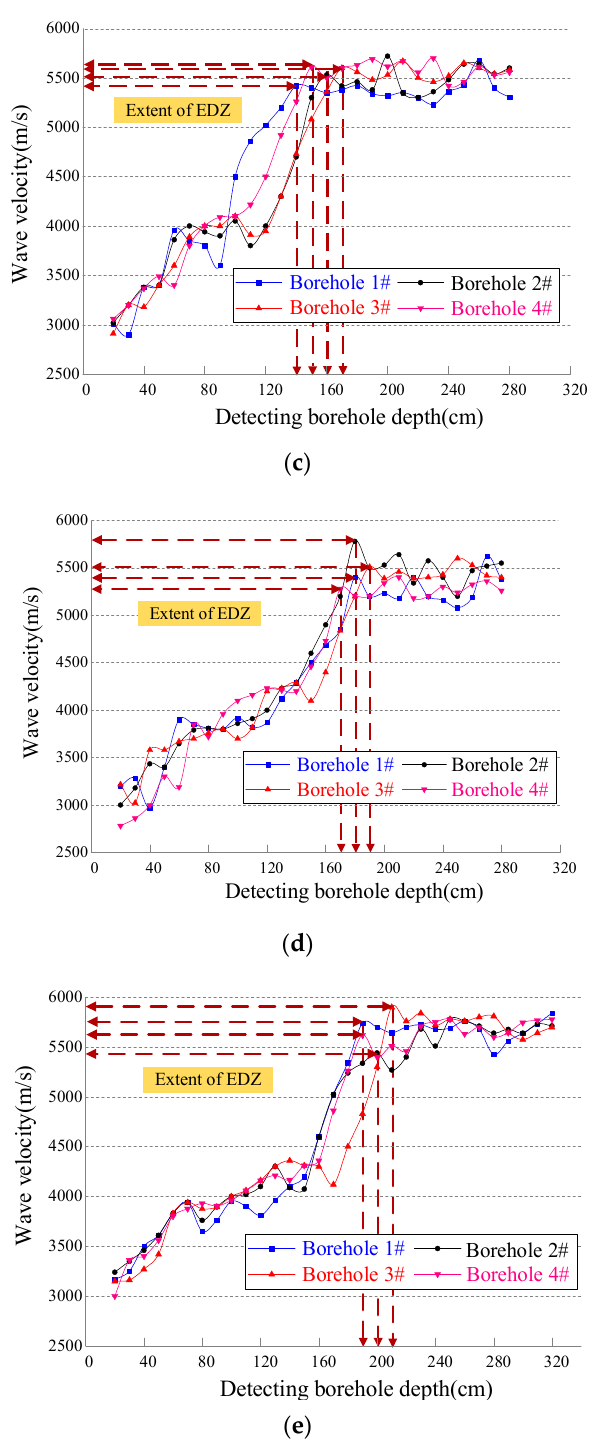
Figure 4. Field detection results of excavation-damaged zone (EDZ): ( a ) thickness of EDZ in the roadway I; ( b ) thickness of EDZ in roadway II; ( c ) thickness of EDZ in roadway III; ( d ) thickness of EDZ in roadway IV; ( e ) thickness of EDZ in roadway V.